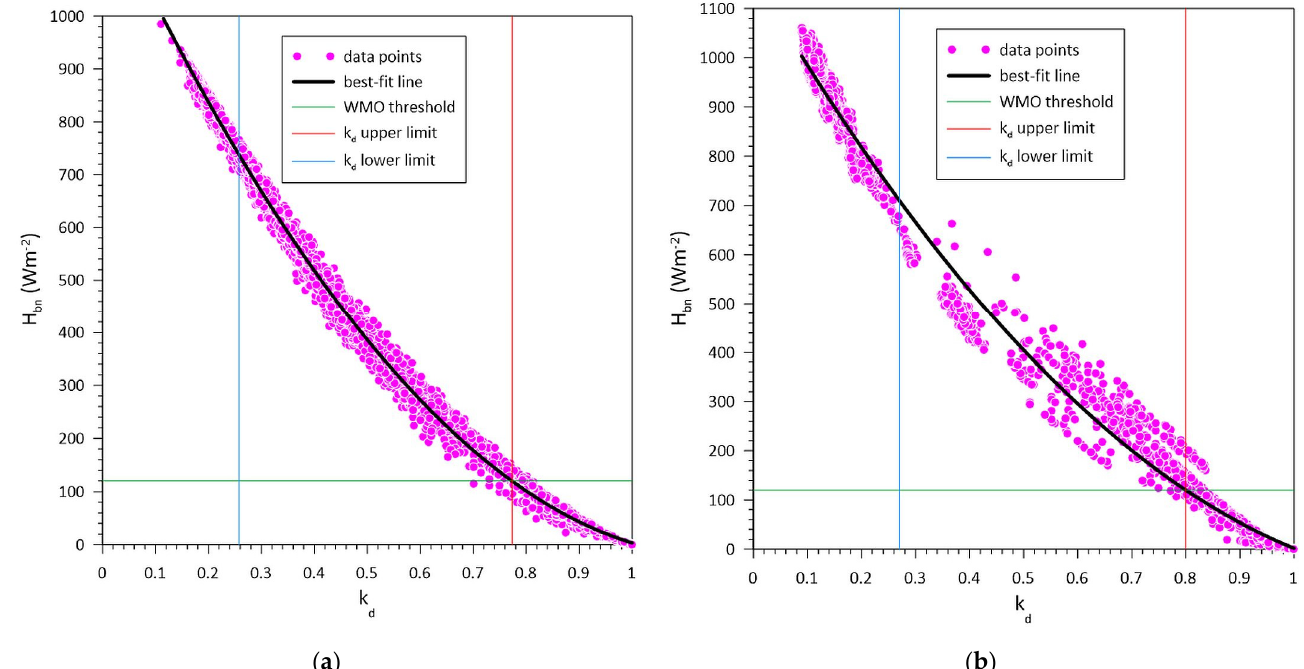
Figure 6. Determination of the k du (red line) and k dl (blue line) values for the ( a ) GAN and ( b ) OHY sites.